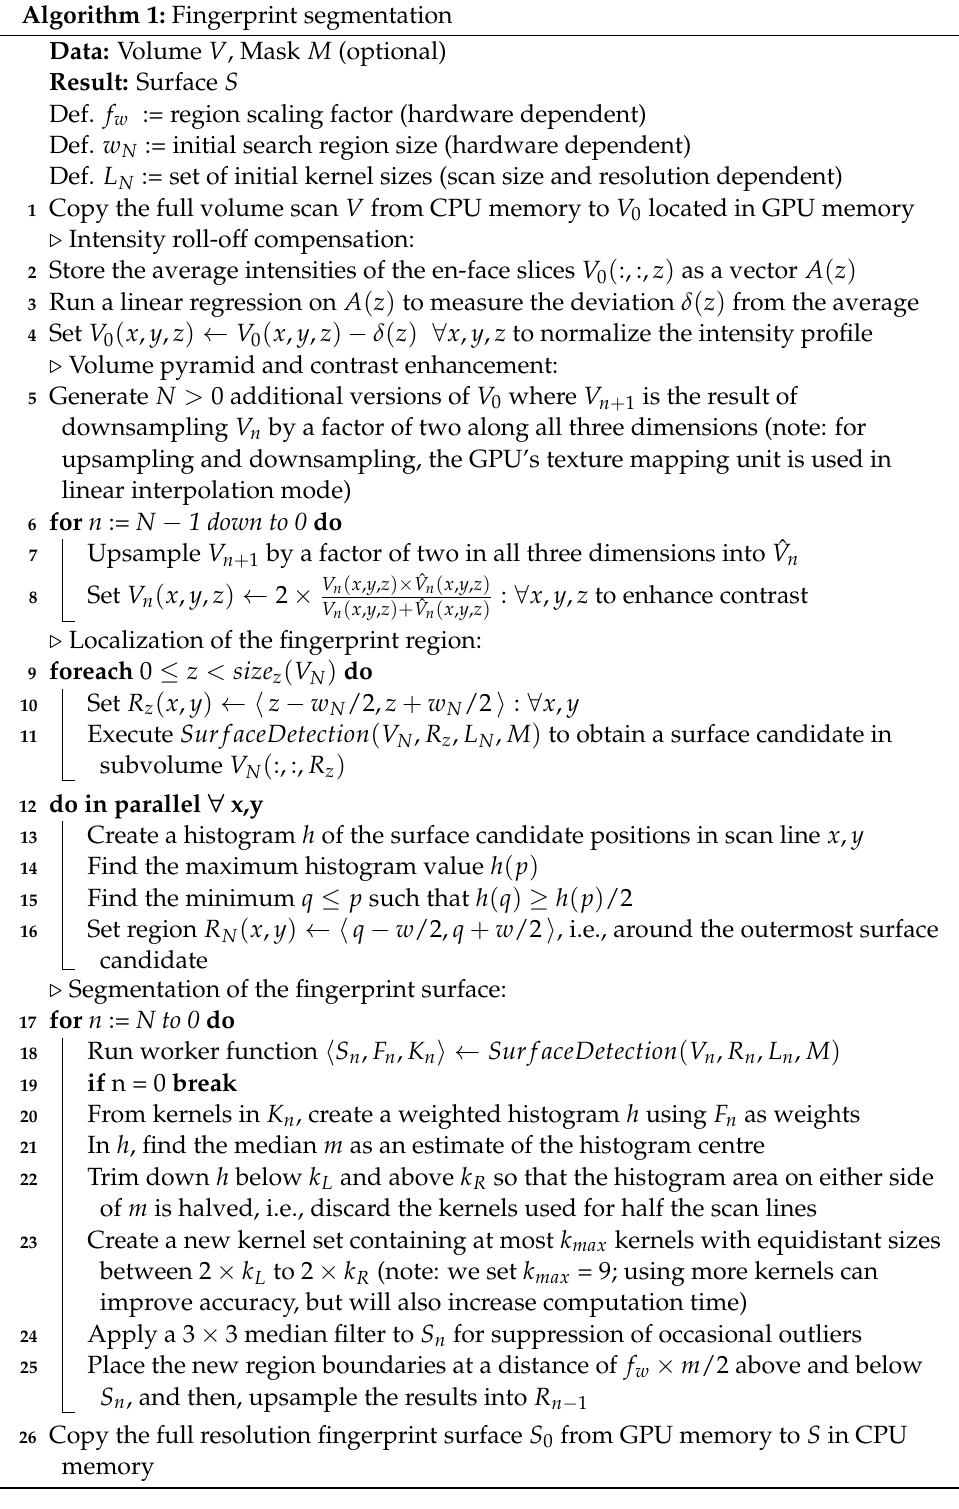
Algorithm 1: Fingerprint